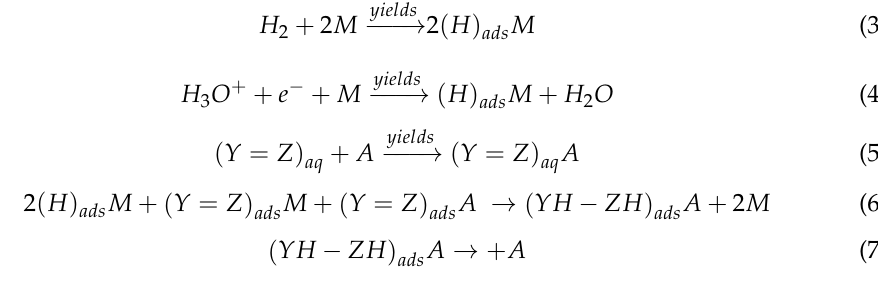
external electrons, as shown in Equation (4), where M represents the metal active site for